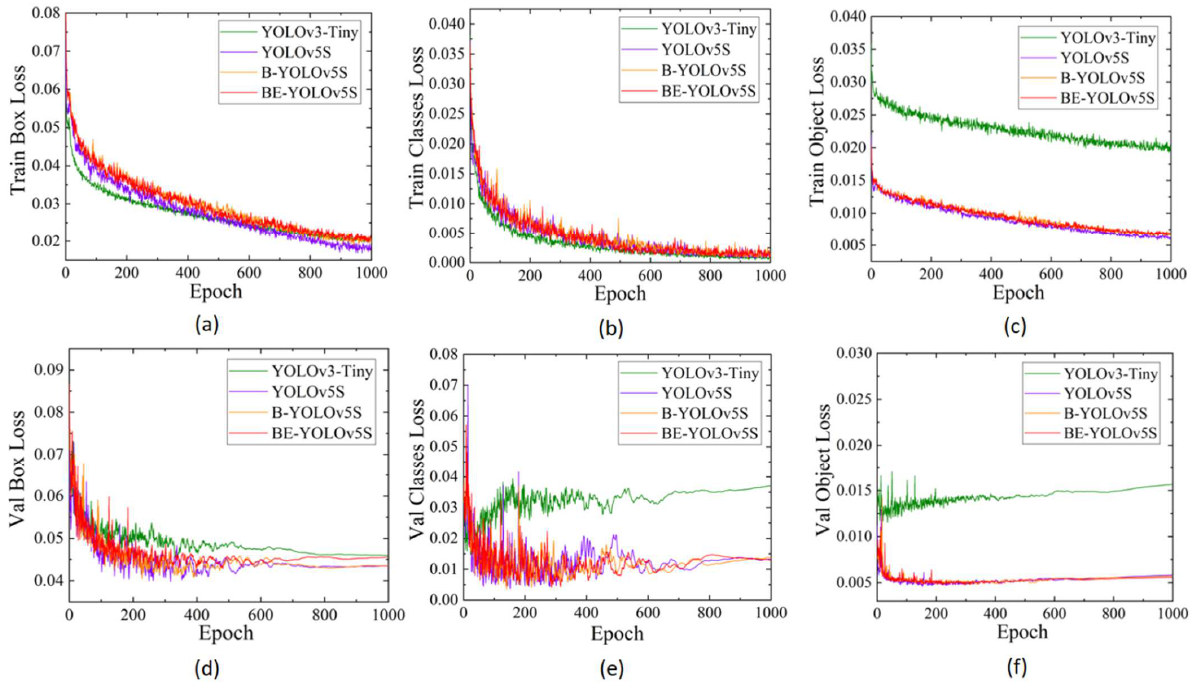
Figure 6. Plots of training and loss functions for four types of models during the experiment. ( a ) Diagram of Train Box Loss function; ( b ) Diagram of Train Classes Loss function; ( c ) Diagram of Train Object Loss function; ( d ) Diagram of Value Box Loss function; ( e ) Diagram of Value Classes Loss function; ( f ) Diagram of Value Object Loss function.